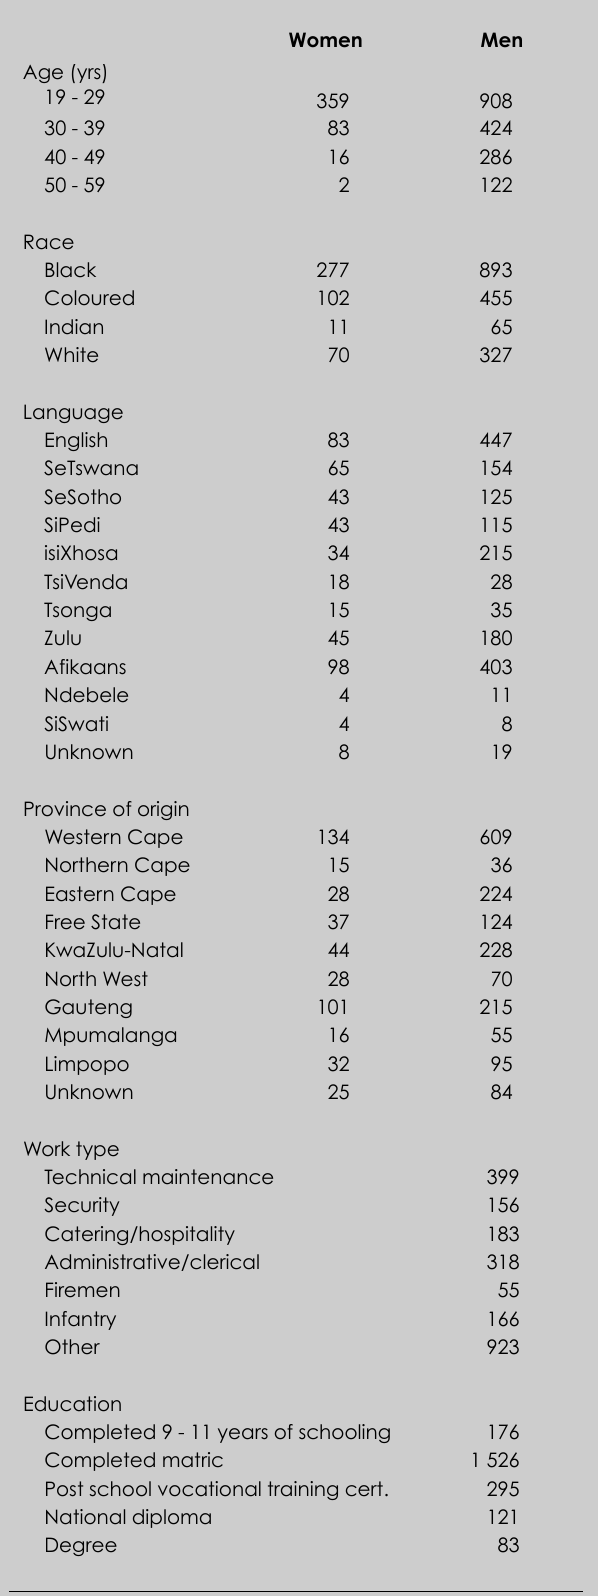
Table I. Distribution of sample in age categories, race, lan- guage, province of origin, work type and